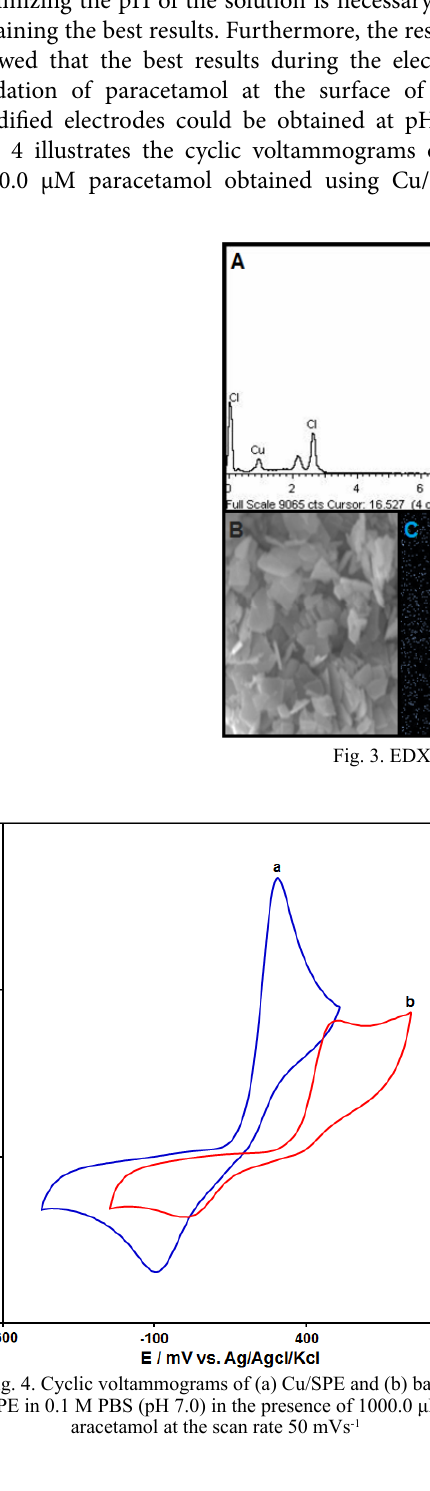
Nanochem Res 2(1): 151-158, Winter and Spring 2017